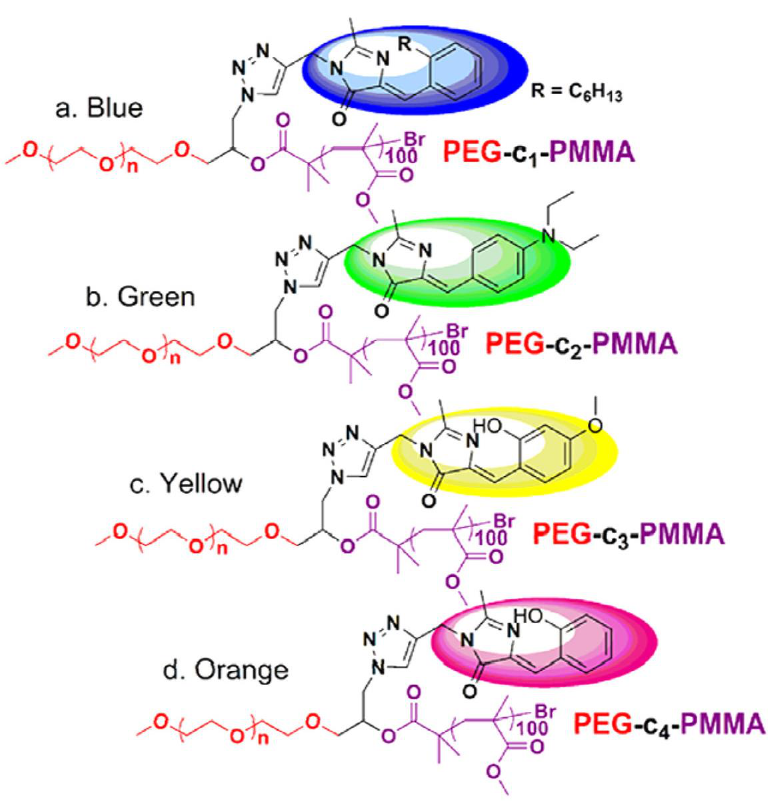
Figure 6. Polymer structure and their fluorescent color dependence on the fluorophore attached: ( a ) blue, ( b ) green, ( c ) yellow, and ( d ) orange. Adapted with permission from reference [74]. Copyright 2015, American Chemical Society.